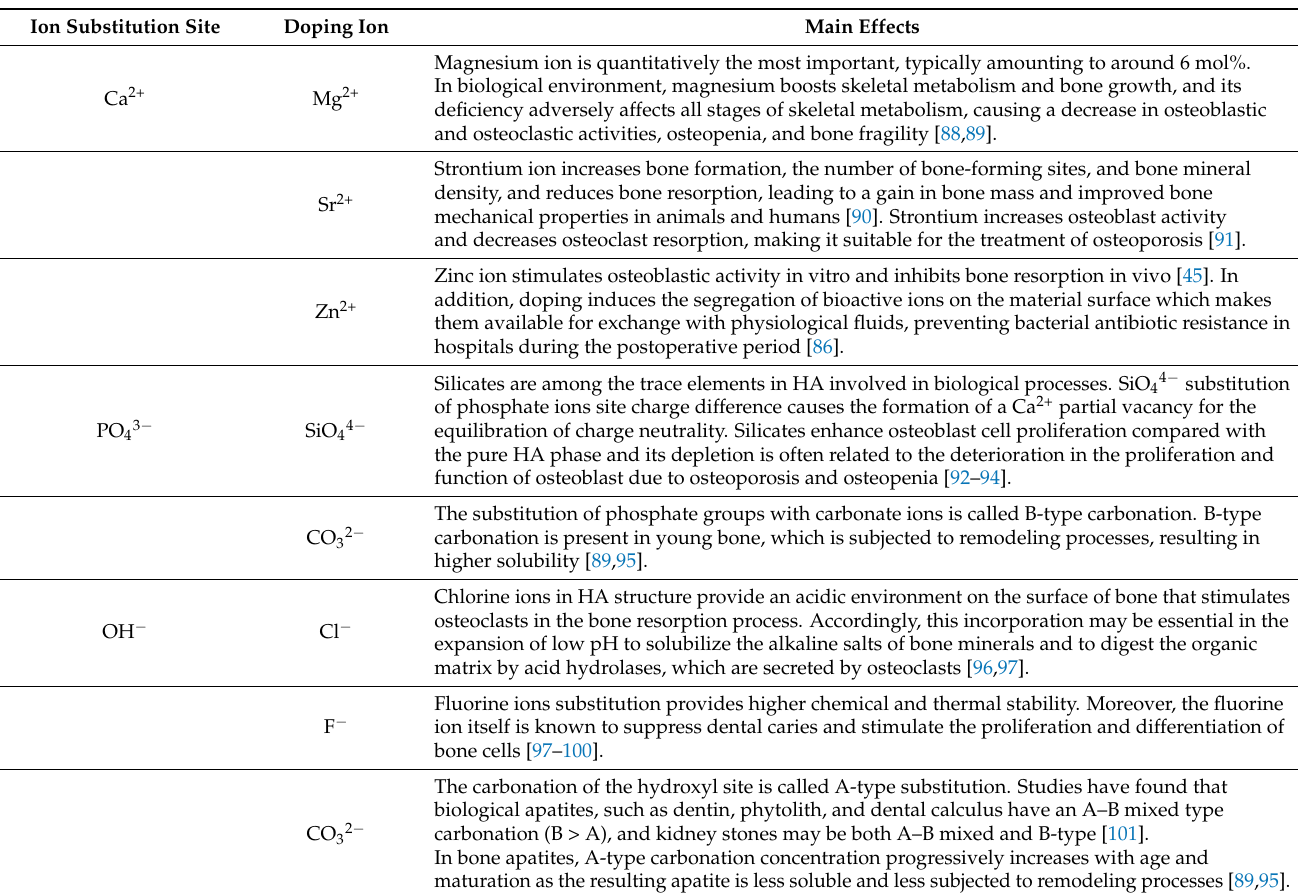
Table 1. Main ions doping bone mineral and their biological